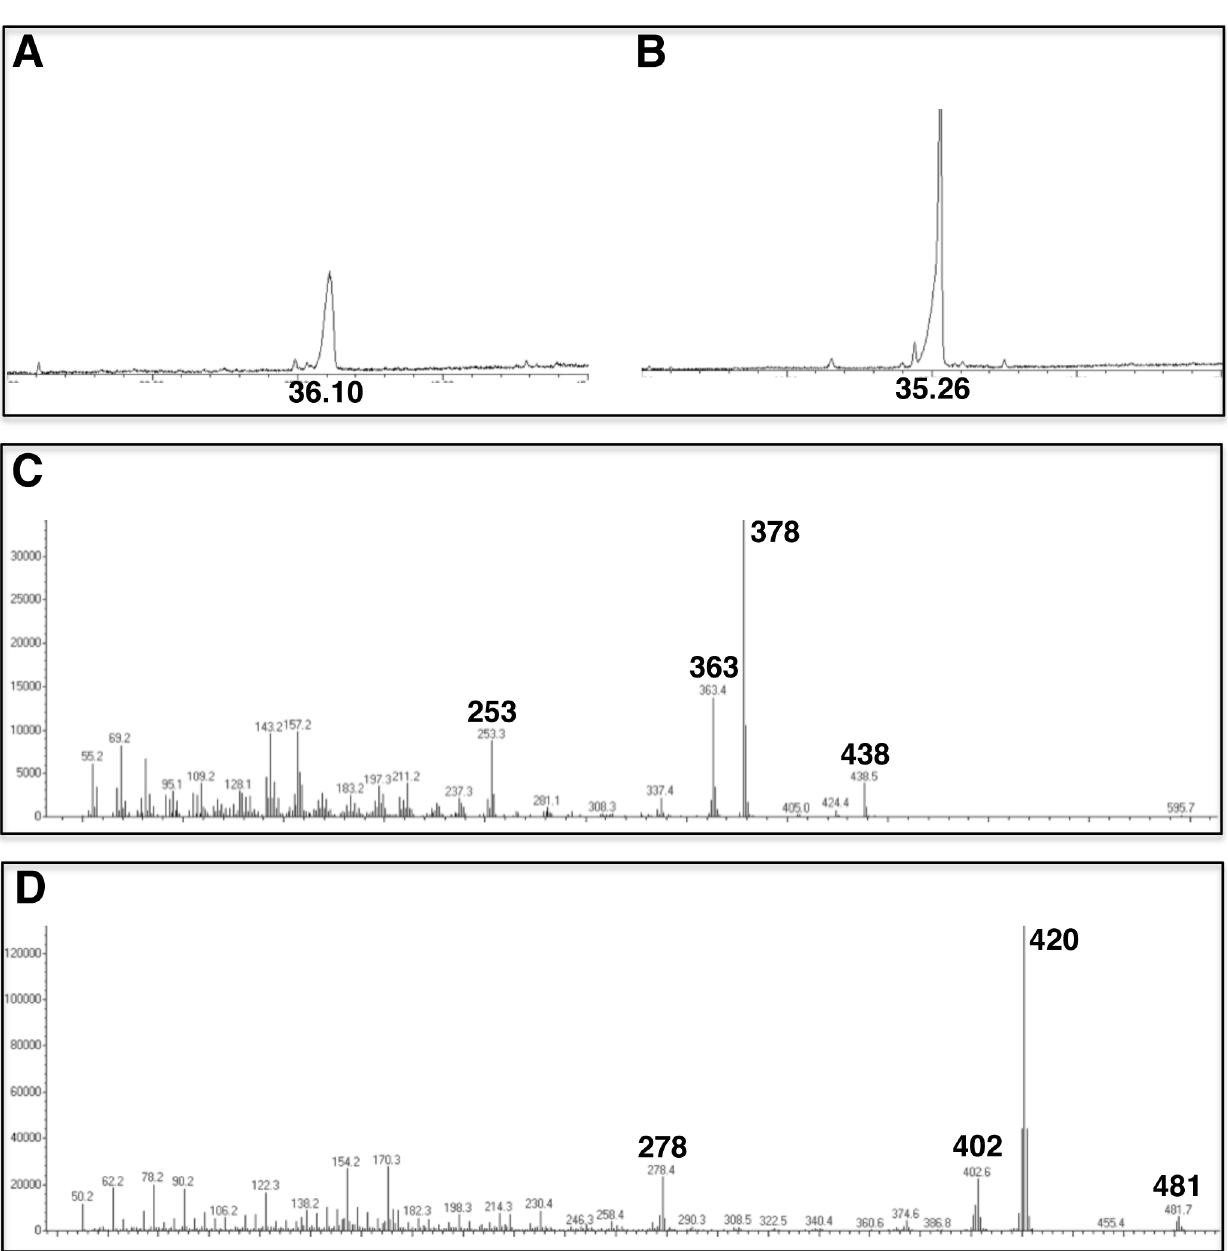
Figure 5. GC-MS analysis of ergosterol isotopomers from Pichiapastoris unsaponifiable extracts. A, TIC of an acetylated extract from cells grown in hydrogenated medium. The peak at RT=36.10 min is ergosterol. B, TIC of an acetylated extract from cells grown in deuterated medium. The peak at RT=35.26 min is deuterioergosterol. C, mass spectrum of ergosteryl acetate. Prominent ions and interpretation of the fragmentation pattern: M + (438), M + -acetate-H (378), M + -acetate-H-CH 3 (363), M + -acetate-H-side chain (253). D, mass spectrum of deuterioergosteryl acetate. Prominent ions and interpretation of the fragmentation pattern: M + (481), M + -acetate-D (420), M + -acetate-D-CD 3 (402), M + -acetate-D-side chain (278).